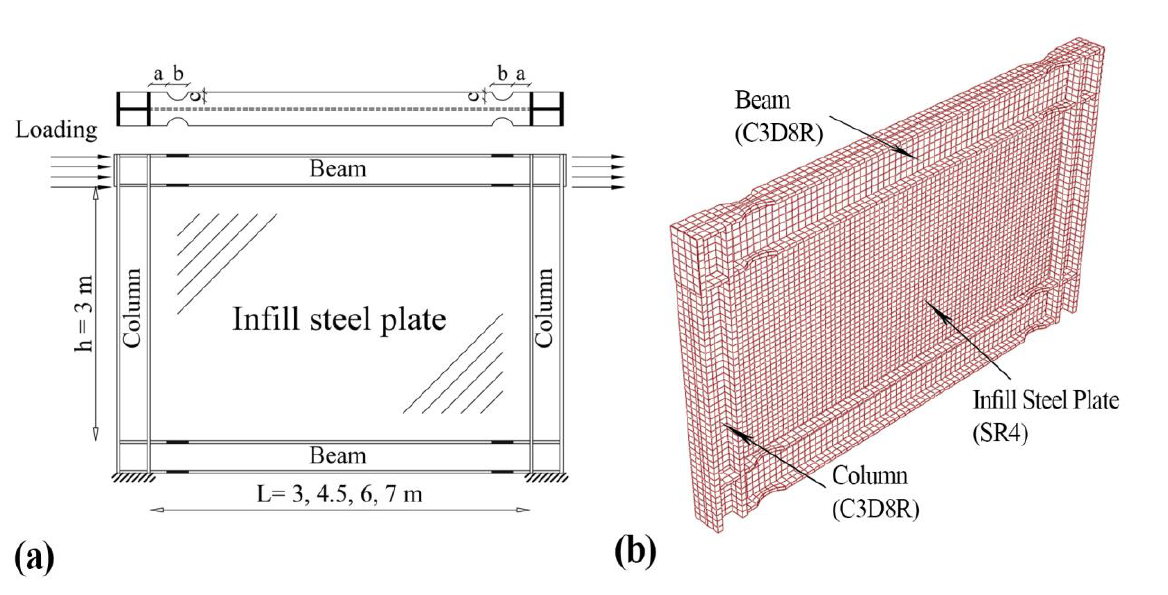
Fig. 1 . A typical finite element of SPSW model. Specifications of the beams and columns in SPSW